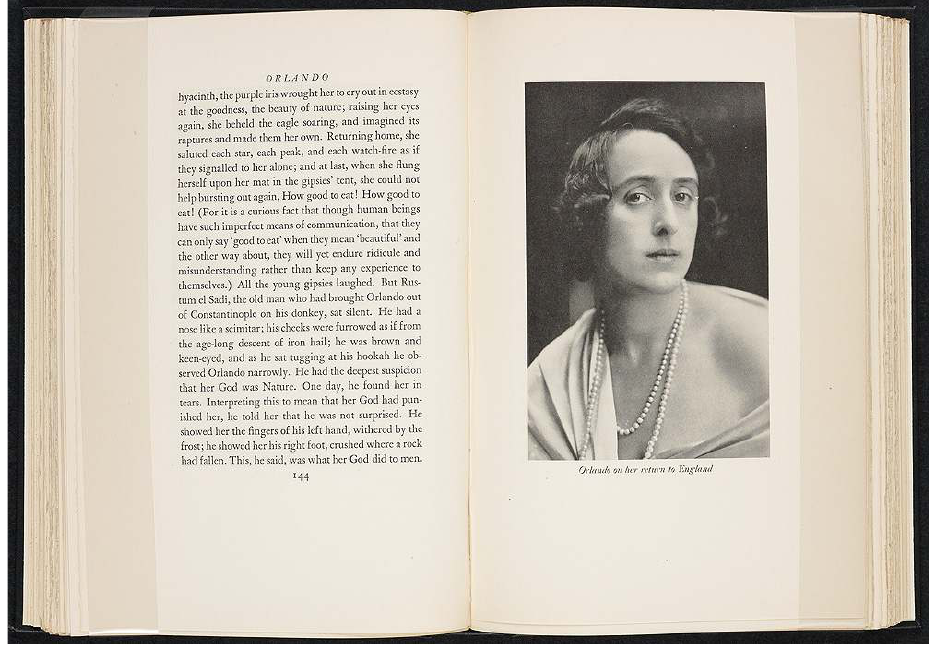
Page 145 shows a photograph purportedly of